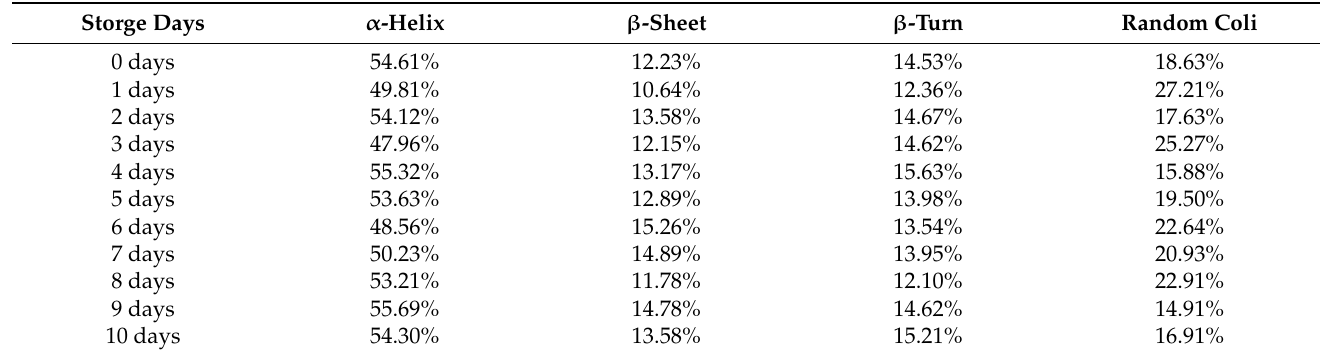
Table 1. Changes in the spatial protein content of rice protein when the relative humidity is 80% and the storage temperature is 20 ◦ C.